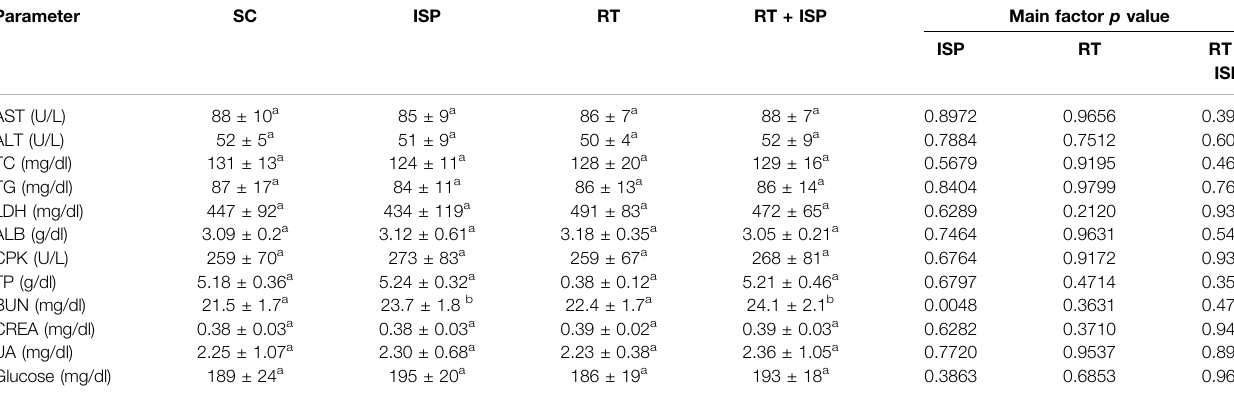
TABLE 3 | Effect of ISP supplementation and RT on biochemical assessments of serum at the end of the experiment. Parameter SC ISP RT RT + ISP Main factor p value